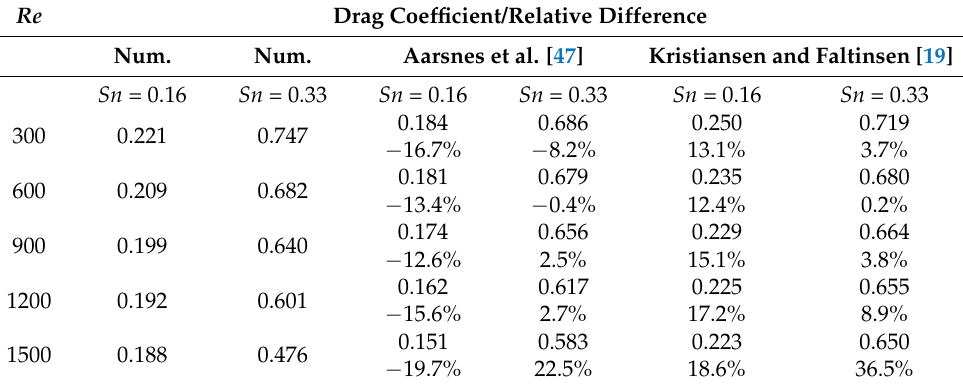
Figure 4. Dependence of the drag coefficients of the flexible net panels on the Reynolds number [19,47]. Table 3. Comparison of numerical predictions and analytical models of drag